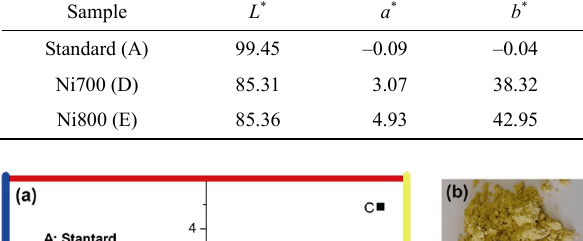
Table 2 Colorimetric coordinates ( L * , a * , and b * ) of NiWO 4 samples calcined at 700 and 800 ℃ /2 h, using light source type D65-10° (day light), following the CIE-L*a*b* standard colorimetric method Sample